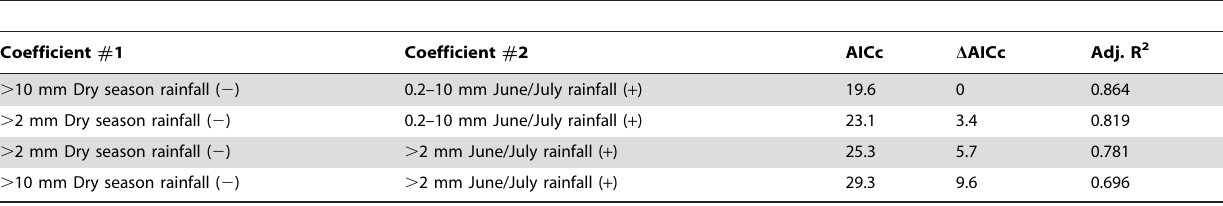
D AICc represents the difference between a model’s mean AICc value and the mean AICc value of the best fit overall model. + / 2 symbol after the coefficient names indicates whether the coefficient value is positive or